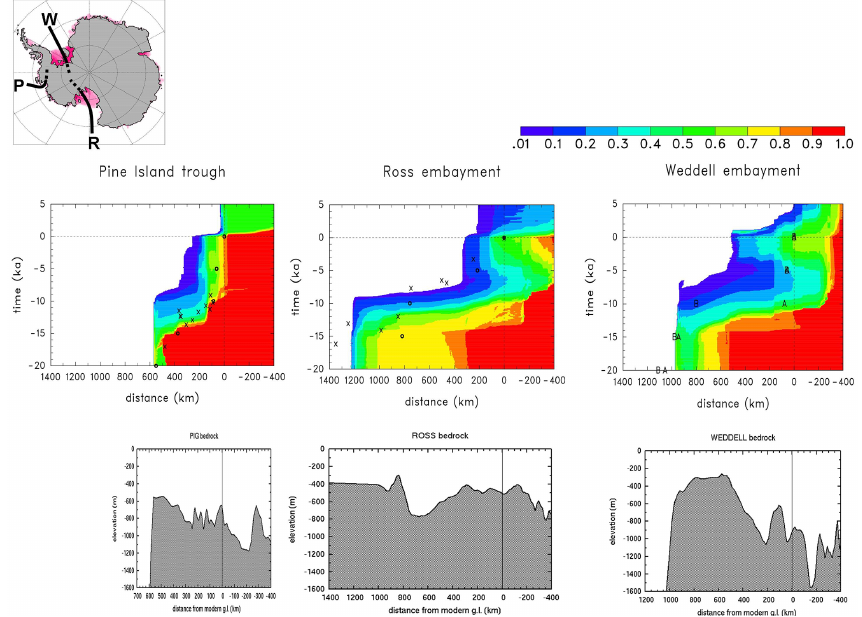
Figure D5. Upper panels: score-weighted probability (0 to 1) of grounded ice vs. time, as in Fig. D4 but along centerline transects of (i) Pine Island Glacier and its paleo-trough, (ii) Ross embayment and (iii) Weddell embayment. Black symbols show various published data: Pine Island, circles: Larter et al. (2014) (the RAISED Consortium, 2014). Pine Island, crosses: Kirshner et al. (2012), Hillenbrand et al. (2014) and Smith et al. (2014). Ross, circles: Anderson et al. (2014) (the RAISED Consortium, 2014). Ross, crosses: Conway et al. (1999) and McKay et al. (2008). Weddell, “A” and “B”: Hillenbrand et al. (2014) (the RAISED Consortium, 2014), Scenarios A and B, respectively. Lower panels: modern bathymetric profiles along each transect (from Bedmap2; Fretwell et al.,